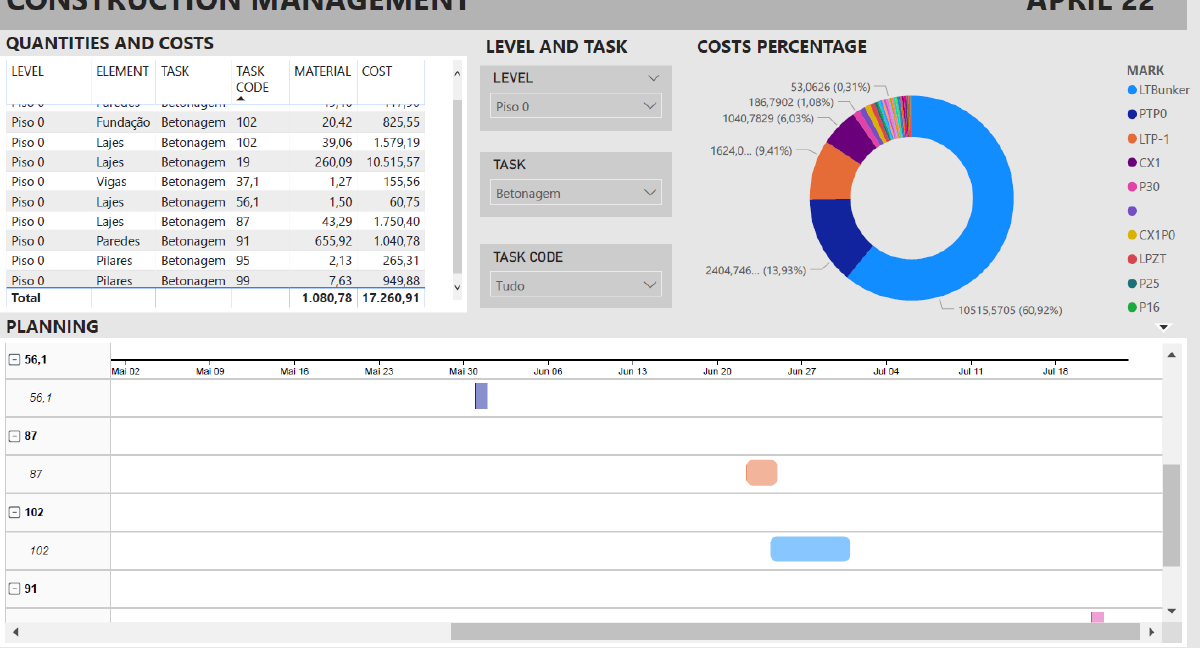
Figure 8. Power BI dashboards—all the construction works.